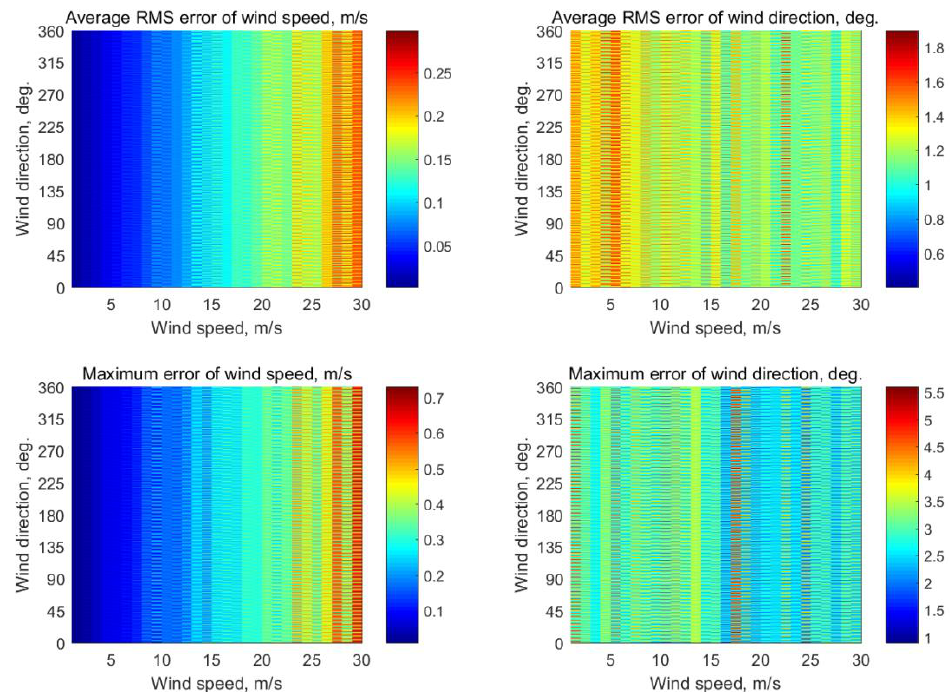
Figure A2. Simulation results of the use of only one incidence angle of 35° for wind retrieval.